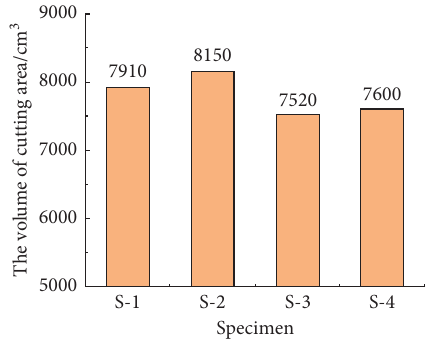
Figure 13: Specimen cavity